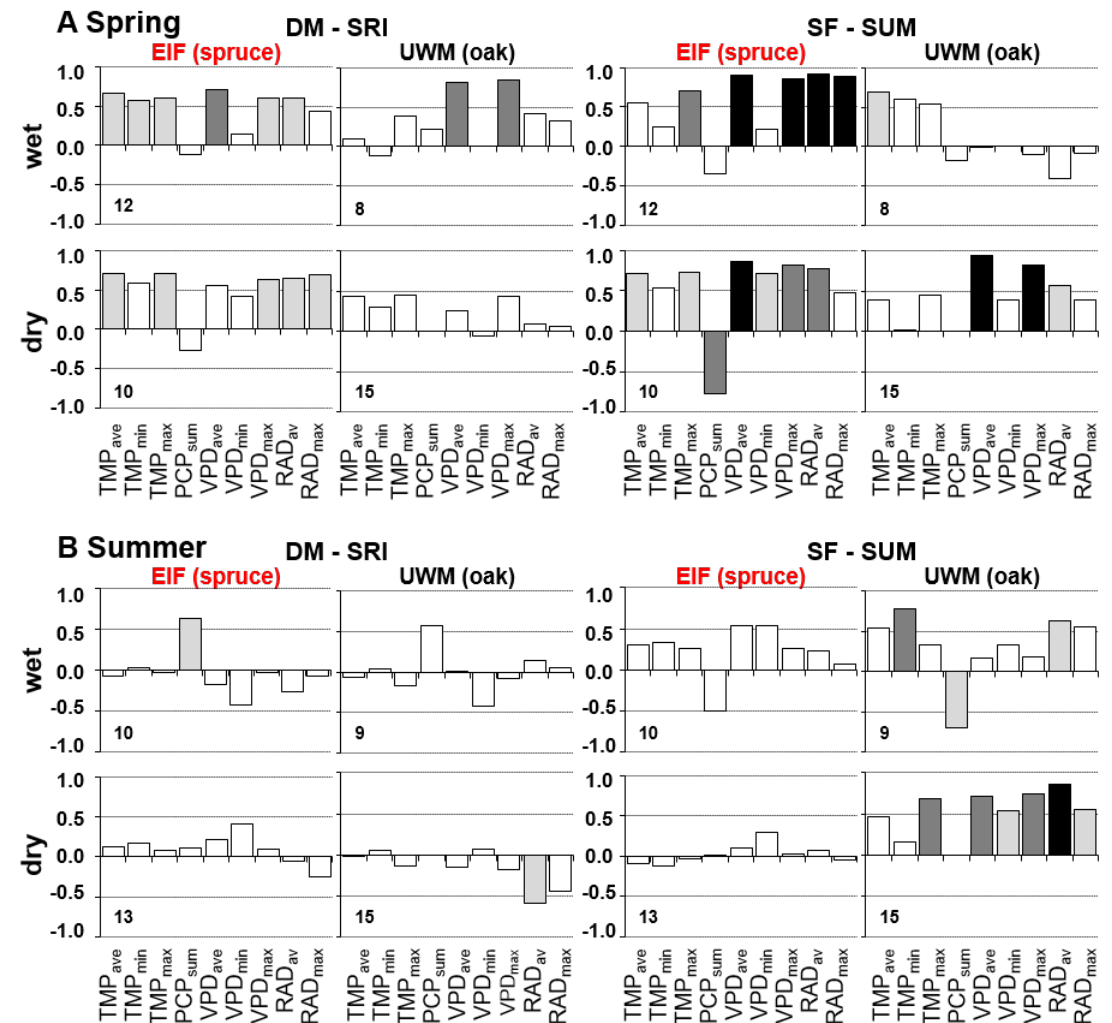
Figure 5. Pearson’s correlations between the two tree type physiological parameters (stem radial increment DM–SRI), daily sum of sap flow (SF–SUM), and daily climate data by research site (EIF/UWM), and synoptic conditions (wet days/dry days) in ( A ) spring and ( B ) summer 2018. Wet days are defined as days with more than 3 mm rainfall, dry days as days with a precipitation sum of less than 3 mm for the actual day and the three days before. Bar colors illustrate levels of significance: black for a = 99.9%, dark grey for a = 99%, and light grey for a = 95%. The digits in the bottom left corner of each correlogram indicate the number of days falling in the analyzed data group. Abbreviations for the climate parameters from left to right: TMP ave = mean daily temperature; TMP min = daily minimum temperature; TMP ma x = daily maximum temperature; PCP sum = daily rainfall sum; VPD ave = mean daily vapor pressure deficit; VPD min = daily minimum of vapor pressure deficit; VPD max = daily maximum of vapor pressure deficit; RAD ave = mean daily solar radiation; and RAD max = daily maximum of solar radiation. At the UWM site, no precipitation was detected on the dry spring and summer days. Therefore, correlations of the tree physiological parameters and precipitation sums were not calculated for this